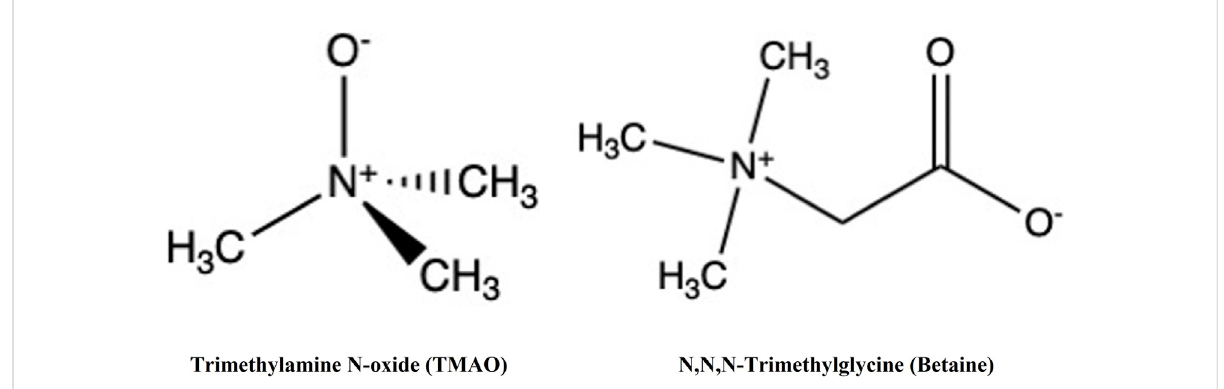
Structure of TMAO and betaine. Both TMAO and betaine belong to methylamine